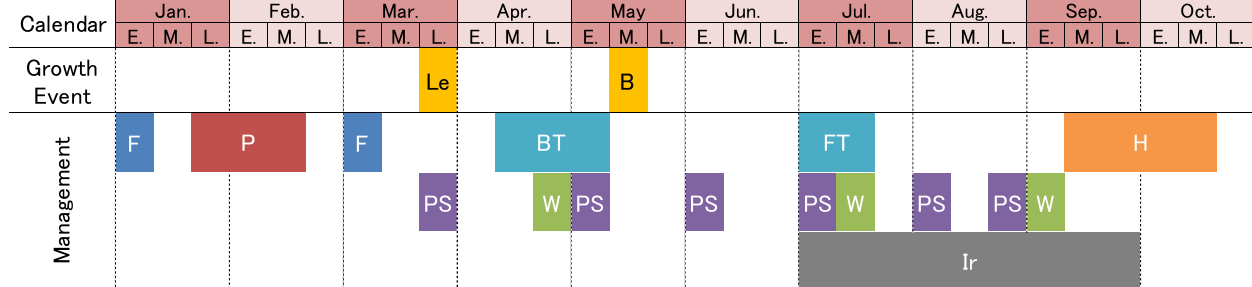
sprayer (Figure 4c). The performance of the